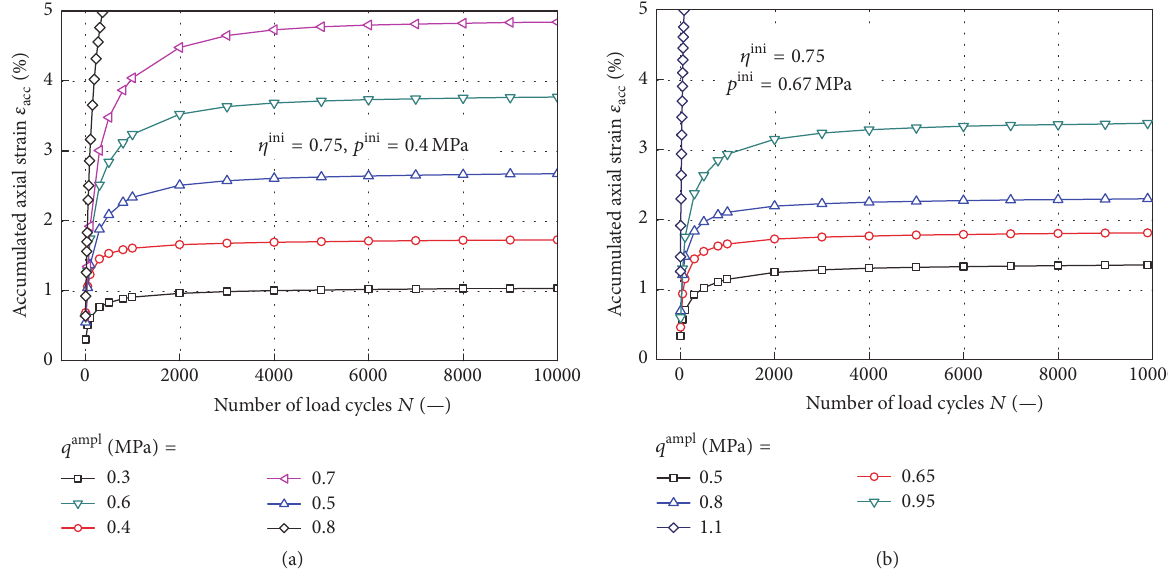
Figure 7: Test with different cyclic stress amplitudes; accumulated axial strain versus number of load cycles: (a) initial mean stress 0.4 MPa; (b) initial mean stress 0.67 MPa.